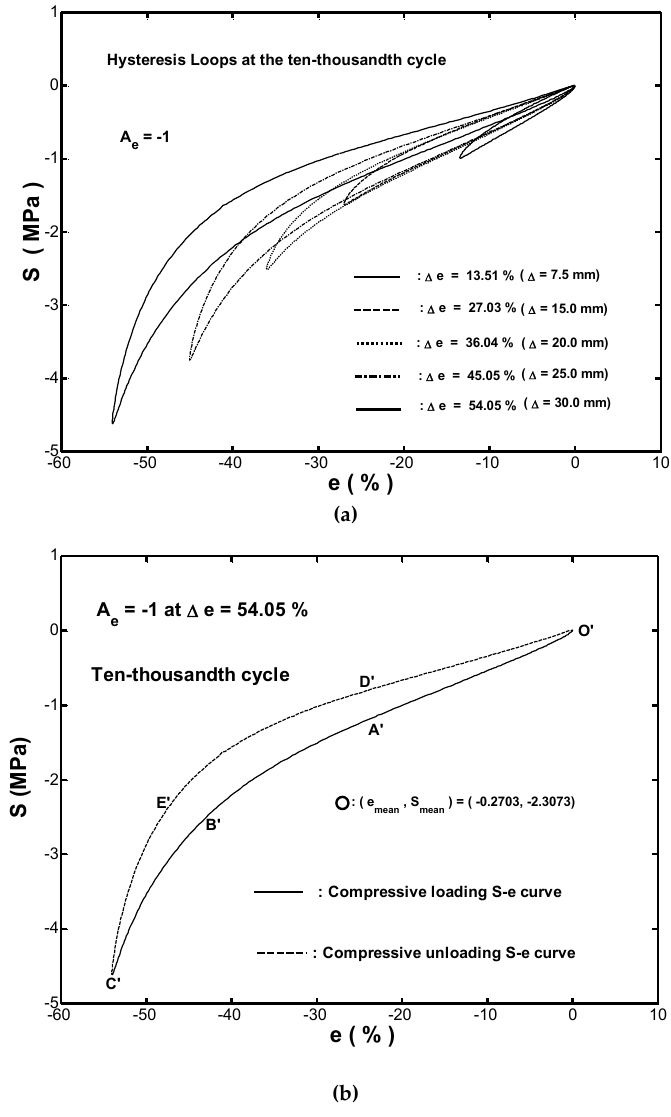
Figure 7. ( a ) Stable hysteresis loops in cyclic compression testing with five different strain ranges ( ∆𝑒 = 13.51%, 27.03%, 36.04%, 45.05%, and 54.05% ). ( b ) Upper and lower branches of stable hysteresis loop for strain range of ∆𝑒 = 54.05% .